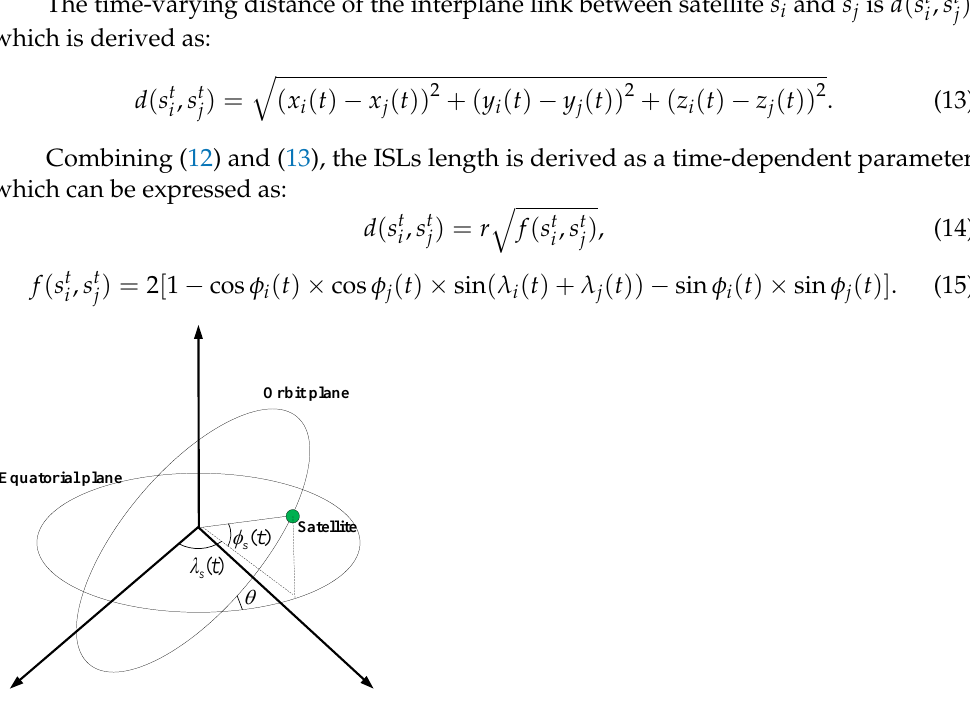
Figure 3. The geometry trajectory of